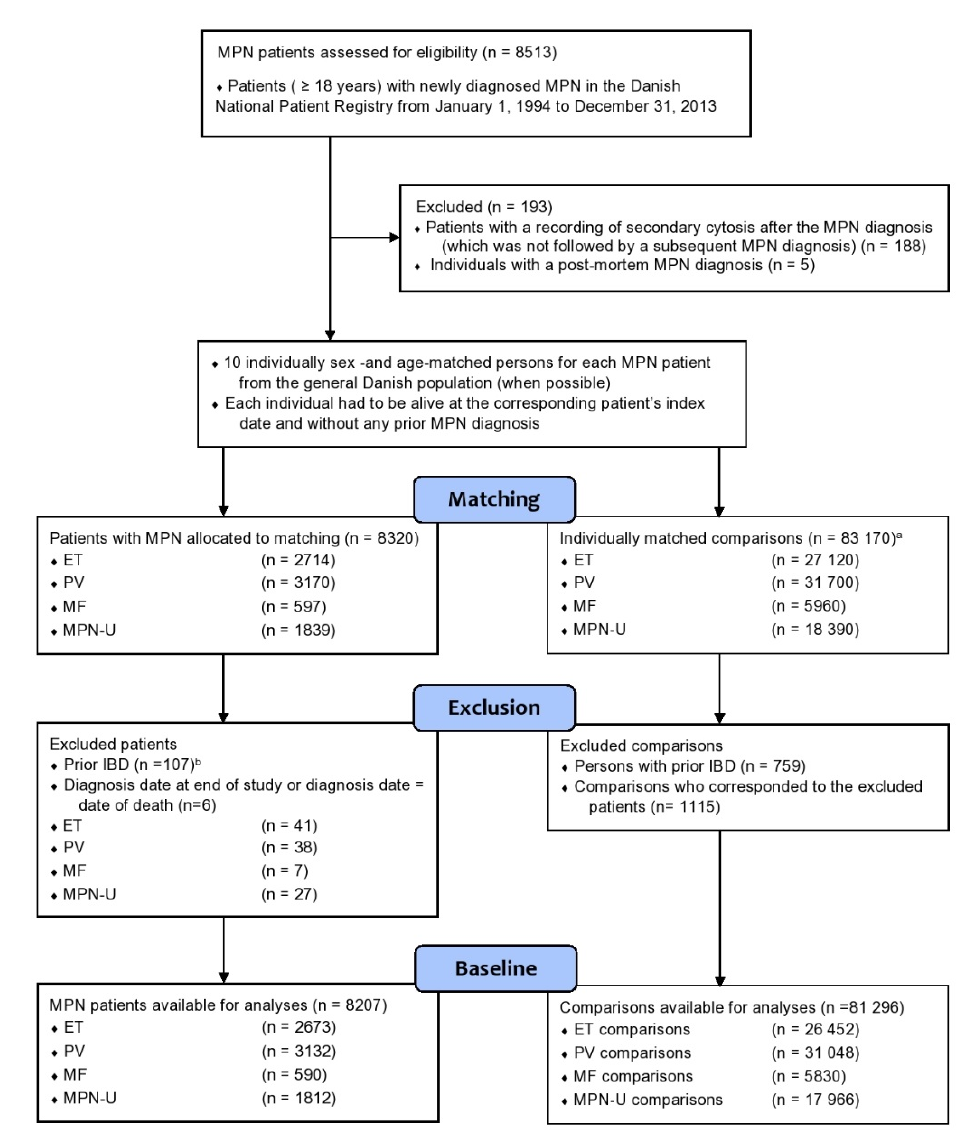
Figure 1. Flowchart of included MPN (myeloproliferative neoplasm) patients (ET (essential thrombocythemia), PV (polycythemia vera), MF (myelofibrosis), and MPN-U (unclassifiable MPN)) and sex- and age-matched comparisons. a For a few patients <10 comparisons could be matched due to old age. b The prevalence of IBD (inflammatory bowel disease) at the time of MPN diagnosis is shown in Table 1.